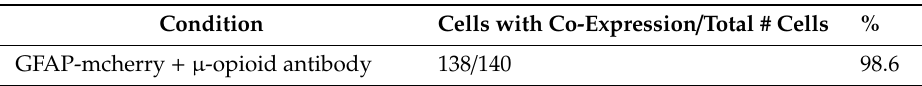
Table 1. GFAP µ -opioid receptor expression